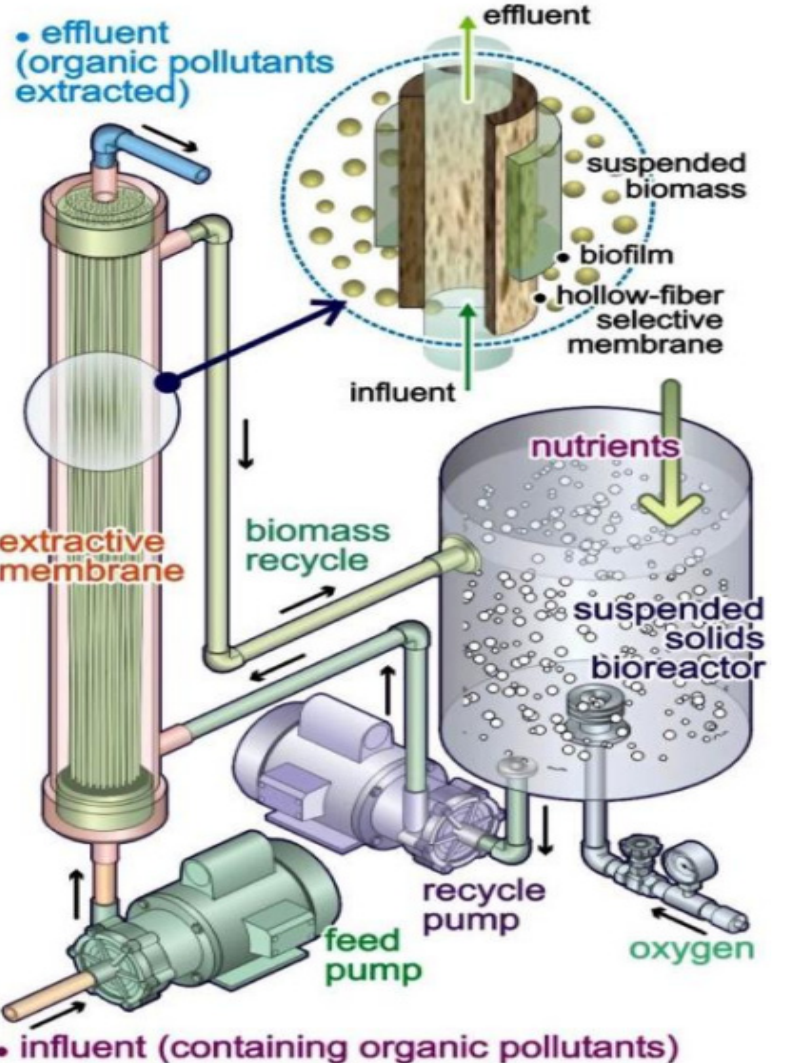
Figure 2. Schematic illustration of micro-contaminant removal using an extractive membrane bioreactor (EMBR). Reprinted from Ref. [25], Copyright (2020), with permission from Elsevier.